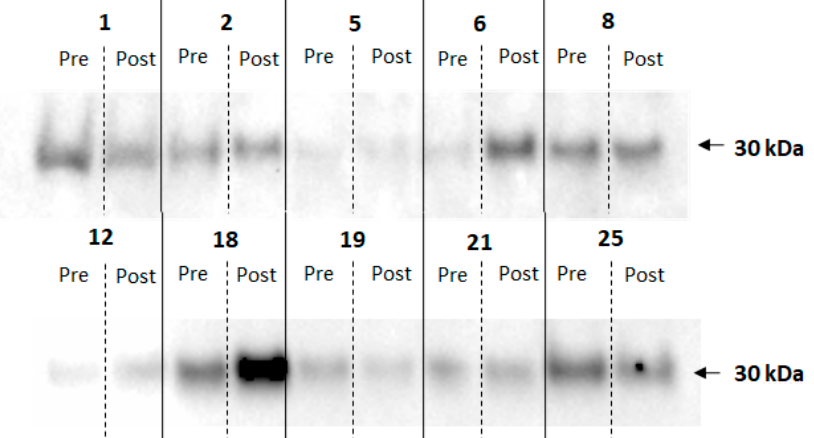
Figure 3. Western blotting of saliva probes from periodontal patients for adiponectin. The numbers correspond to the patient; Pre indicates the saliva sample before and Post after surgery.